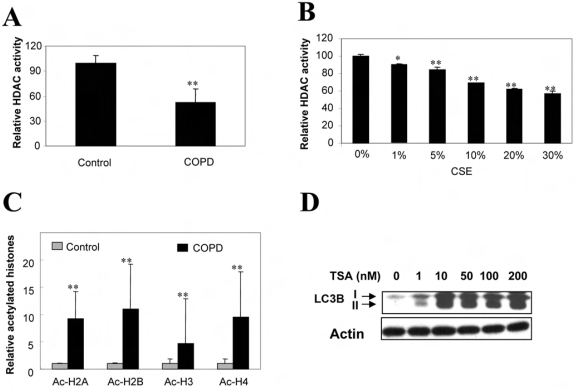
Role of HDAC Activity in COPD and Autophagy.(A) Decreased HDAC activity in lung tissues from COPD patients (n = 5). (B) CSE-dependent reduction of HDAC activity in Beas-2B cells. Cells were treated with various concentrations of CSE for 24 h and subjected for analysis of HDAC activity. (C) Western blot analysis of acetylated histones in human lung tissues. (D) Induction of LC3 by TSA in Beas-2B cells. Cells were treated with the indicated concentrations of TSA for 24 h. (B–C) Data represent mean+/−S.D. of three independent experiments. *indicates P<0.05, ** indicates P<0.01.